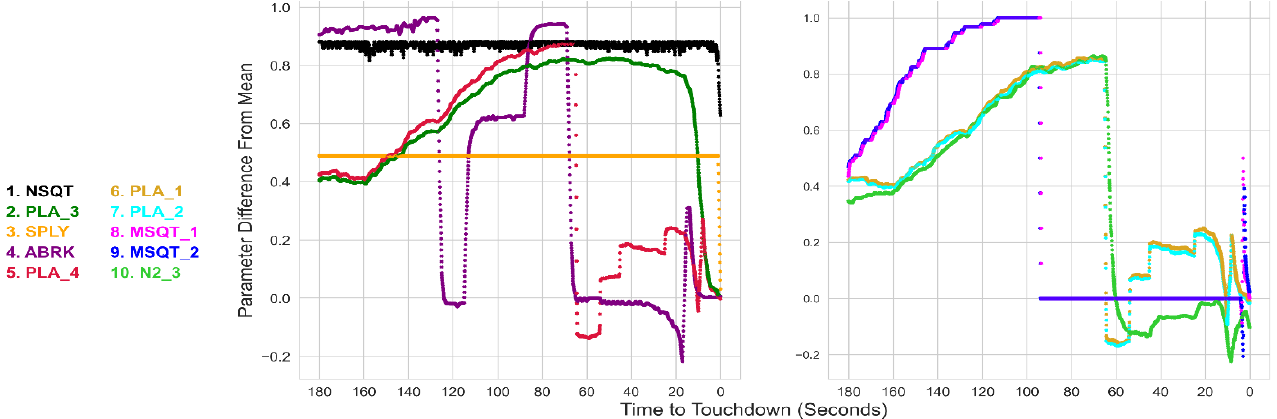
Figure 12. Top 10 flight parameters responsible for an anomalous flight during last 3 min before touchdown.